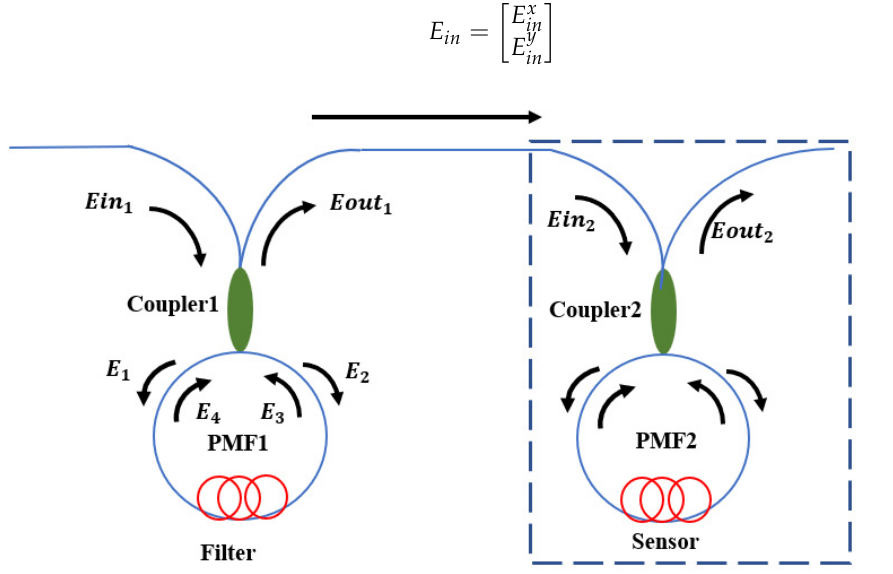
Figure 1. Schematic diagram of the working principle of cascaded Sagnac ring to realize the Vernier effect .